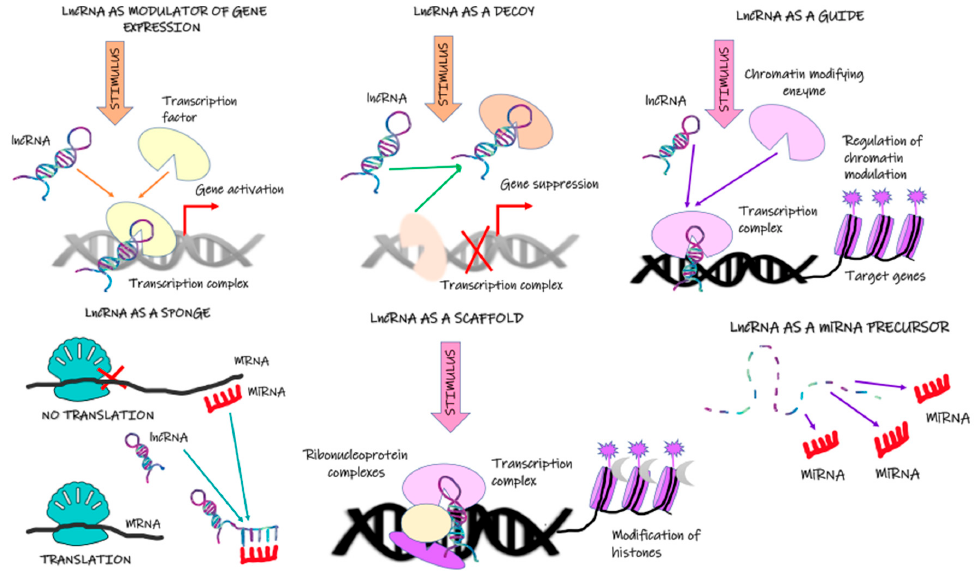
Figure 1. Mechanisms of lncRNA action.